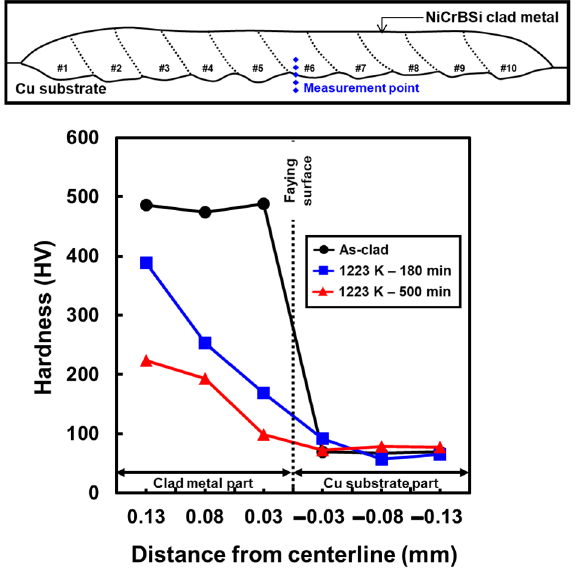
Figure 8. Effect of heat treatment on the hardness distribution along the longitudinal direction near the faying surface.